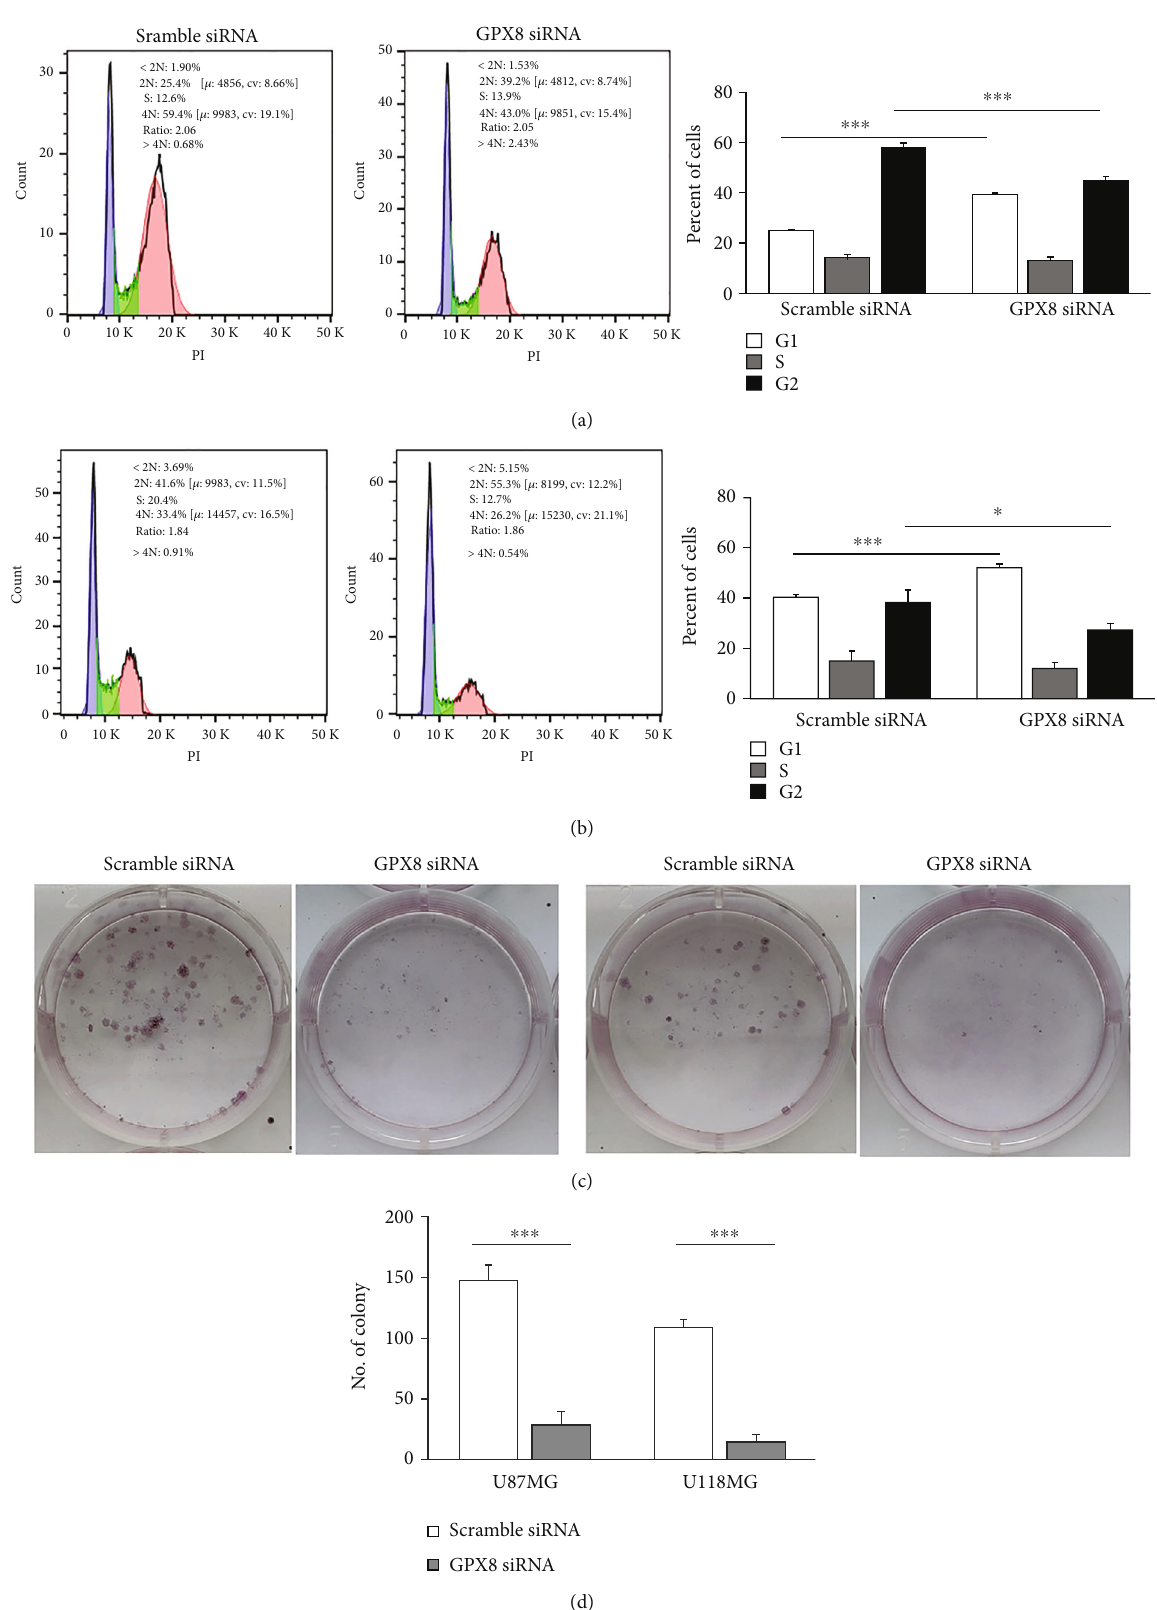
Figure 9: E ff ects of GPX8 on cell cycle and colony formation capacity. (a, b) Cell cycle assay ( ∗ P < 0 : 05 , ∗∗∗ P < 0 : 001 ). G1: 2N; G2: 4N. (c, d) Colony formation capacity assay ( ∗∗∗ P < 0 : 001